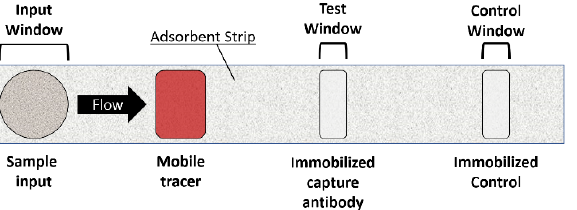
Figure 1. Diagram of an antibody-antigen test strip with its different constituents (sandwich